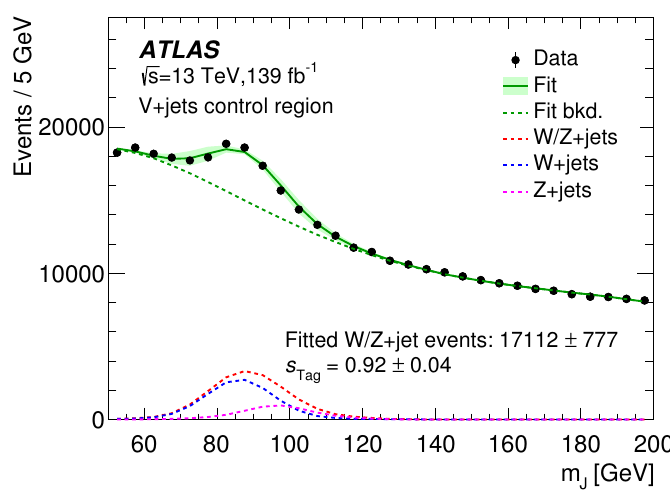
Figure 4 . Jet mass distribution for data in the region enhanced in V + jets events after boson tagging based only on the D and n variables. The result of (cid:12)tting to the sum of functions for the 2 trk V + jets and background events is also shown. The shown (cid:12)t uncertainty re(cid:13)ects the uncertainty in shape and positions of the W and Z peaks. At the bottom, the (cid:12)tted contribution to the observed jet mass spectra from the V + jets signal is shown. The (cid:12)tted relative e(cid:14)ciency of the D